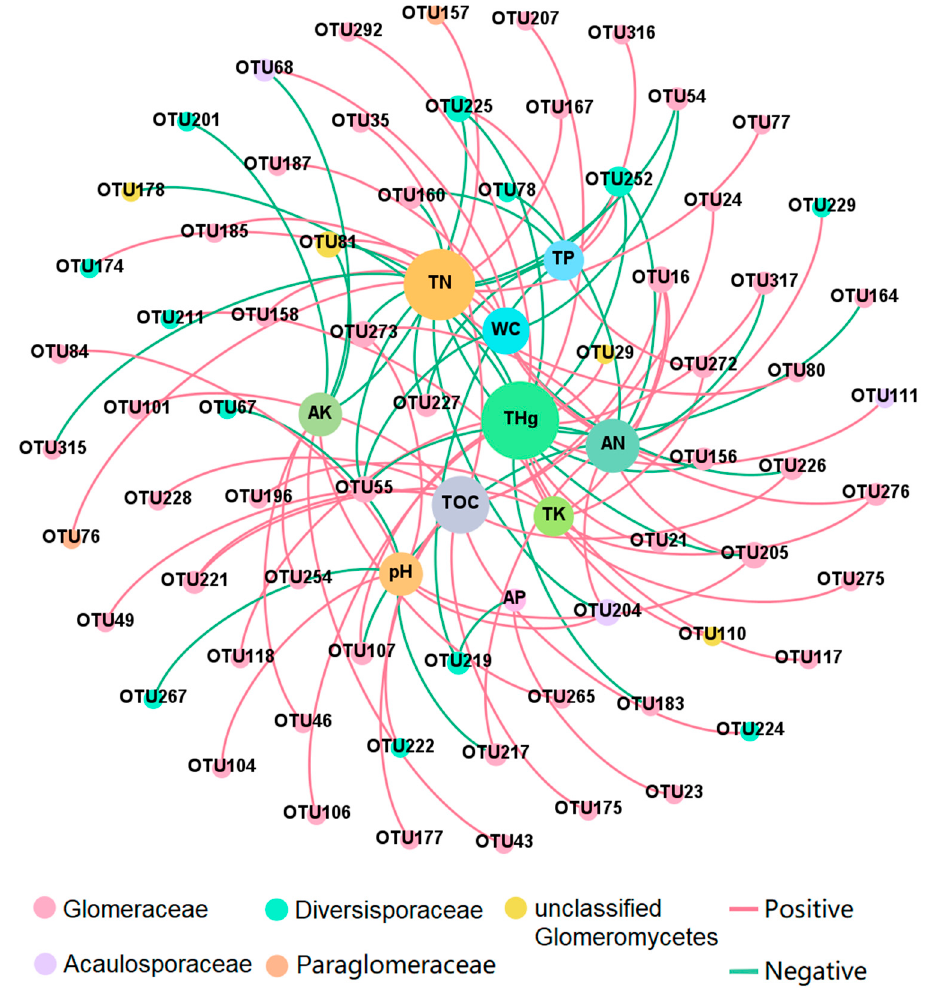
Figure 6. Two-factor network analysis of the association between arbuscular mycorrhizal fungi species and environmental factors of Hg mining area. The different colors of the species represent the family they belong to. The line between the points represents a significant correlation ( p < 0.05) as indicated by the Pearson correlation coefficient. THg: total mercury; AK: available potassium; AP: available phosphorus; AN: available nitrogen; TK: total potassium; TP: total phosphorus; TN: total nitrogen; TOC: total organic carbon; WC: water content.